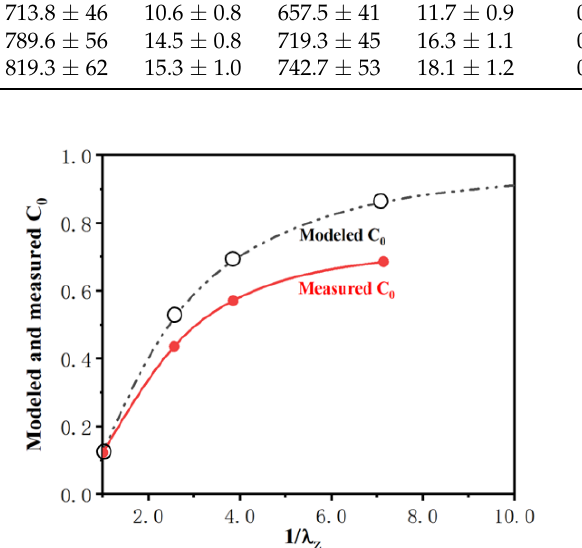
Figure 12. Modeled and measured strengthening factor ( C 0 ) of TiB fibers in the composite.